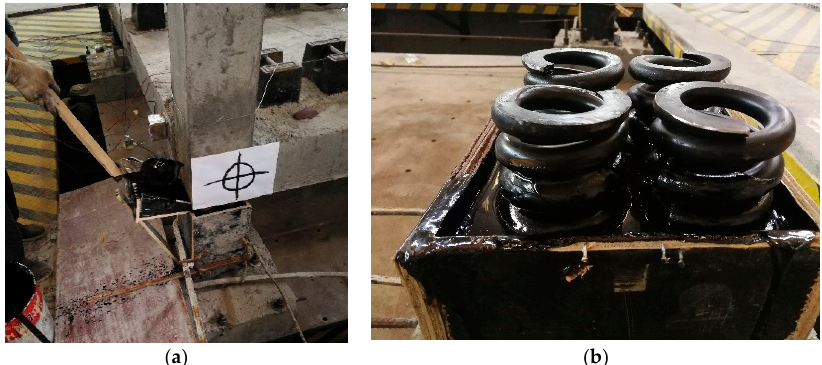
Figure 13. Pouring the asphalt into the isolation bearings: ( a ) the procedure; ( b ) the isolation bearing with asphalt.